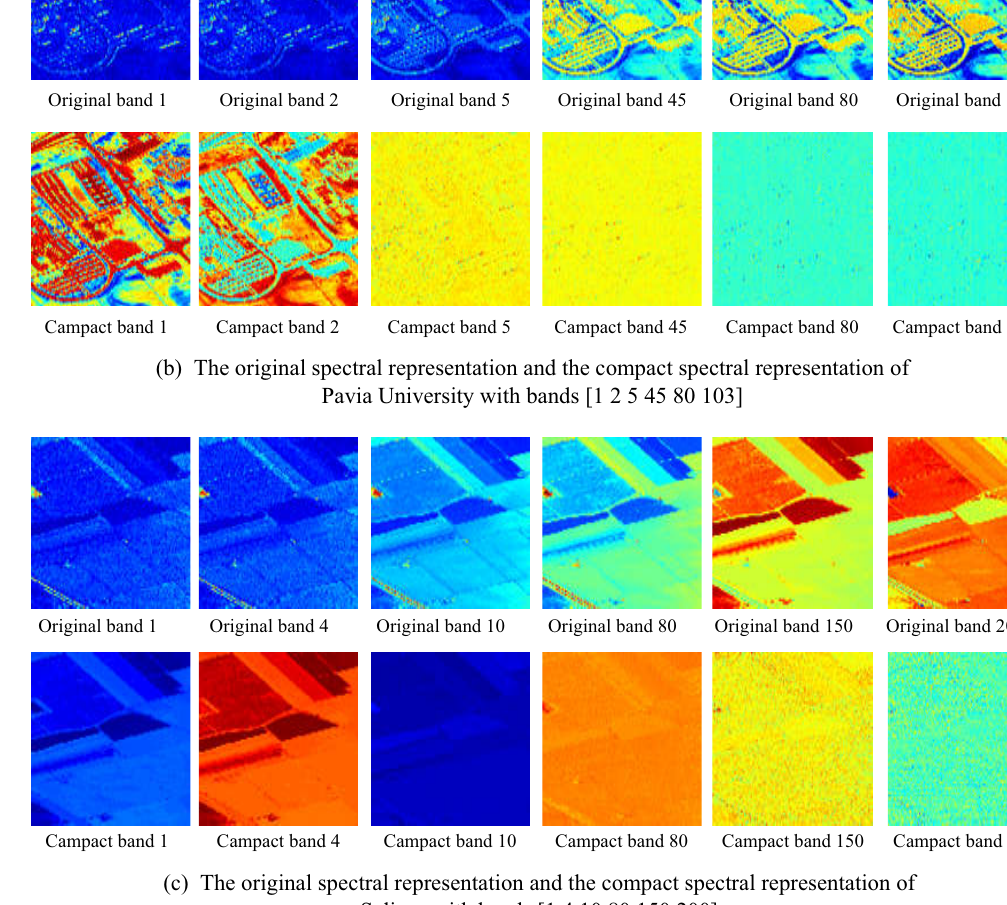
Figure 2. The compact representation of hyperspectral